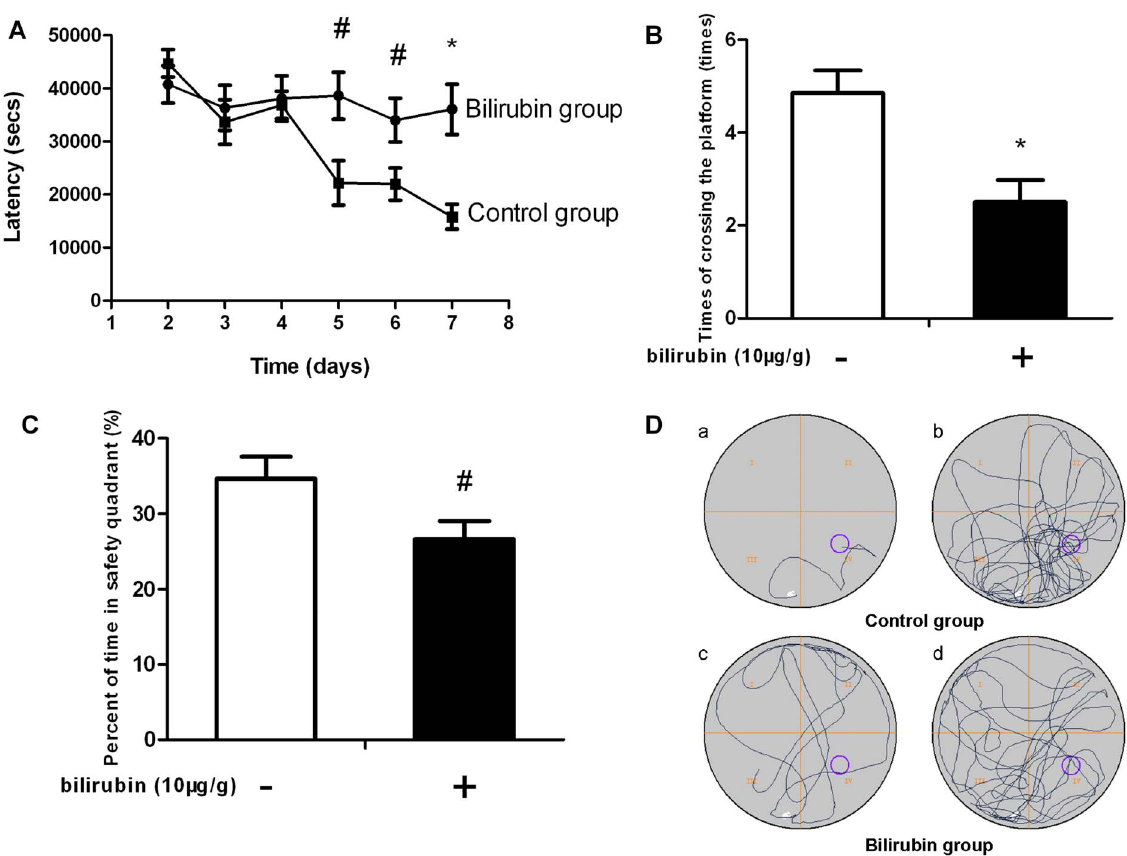
Figure 4. Learning and memory ability based on the Morris water maze test. (A) Escape latency to find the platform from days 2 to 7 of testing. Compared to controls, the bilirubin-treated rats showed a longer latency to escape onto the platform on days 5 to 7 (navigation trial). (B) The number of times the rats crossed over the platform location on day 8 (probe trial). The number of times that the bilirubin-treated rats crossed over the platform location was significantly lower when compared with that of the controls. (C) The percentage of time spent in the safety quadrant during the probe trial. Compared to controls, the bilirubin-treated rats spent less time in the platform safety quadrant. (D) Representative swimming paths. (a), (c): during the navigation trial on day 7. (b), (d): during the probe trial. Data are expressed as the mean 6 SD (n=12 in each group). *: P , 0.01 vs control group; # : P , 0.05 vs control group.